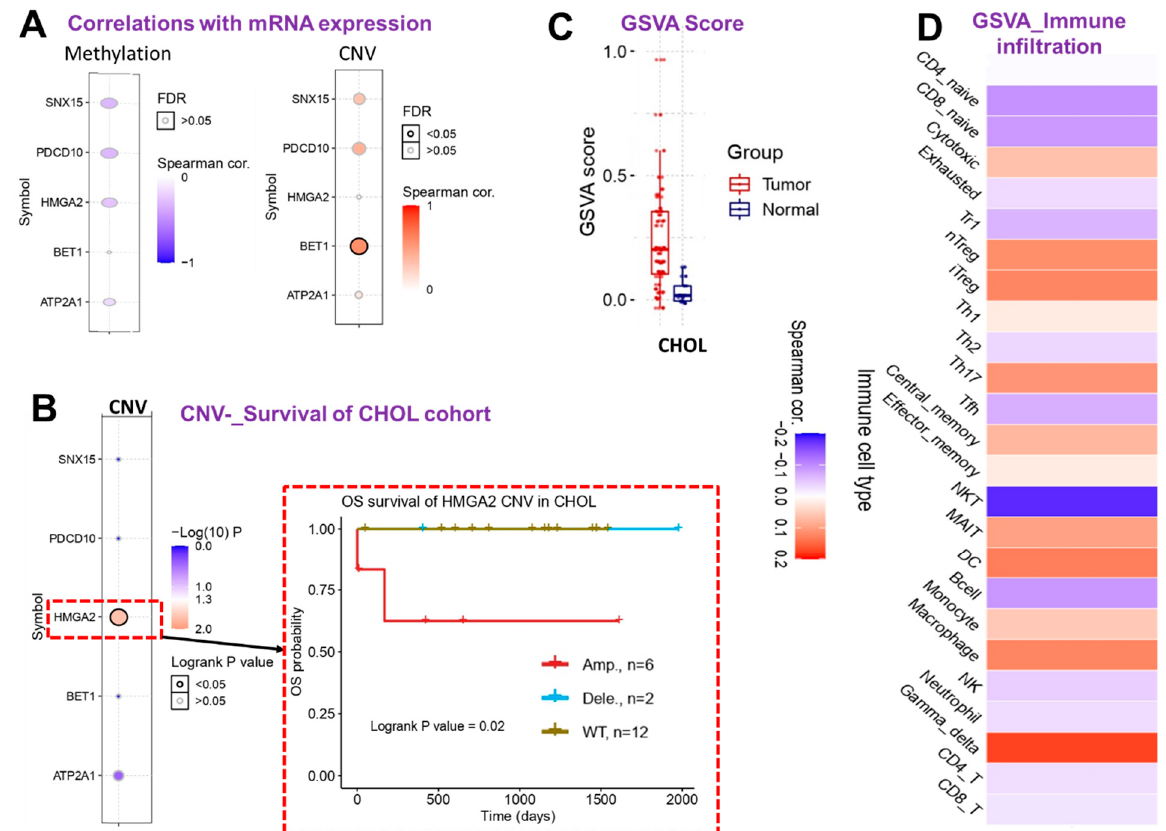
Figure 6. Cholangiocarcinoma (CHOL)-hub gene associations with tumor immune and immunosuppressive cell infiltration in CHOL patients. ( A ) Bubble plot showing correlations of the mRNA expression levels of CHOL-hub genes with methylation and copy number variation (CNV). ( B ) Heat map plot and Kaplan–Meier plot showing survival differences between CHOL patient with CNV of CHOL-hub genes and cohorts with wild-type genes. ( C ) Box plot showing GSVA scores of CHOL-hub genes between CHOL tumor and adjacent normal samples. ( D ) Heatmap showing correlations between GSVA scores of CHOL-hub genes and infiltration levels of various cells in CHOL patients.